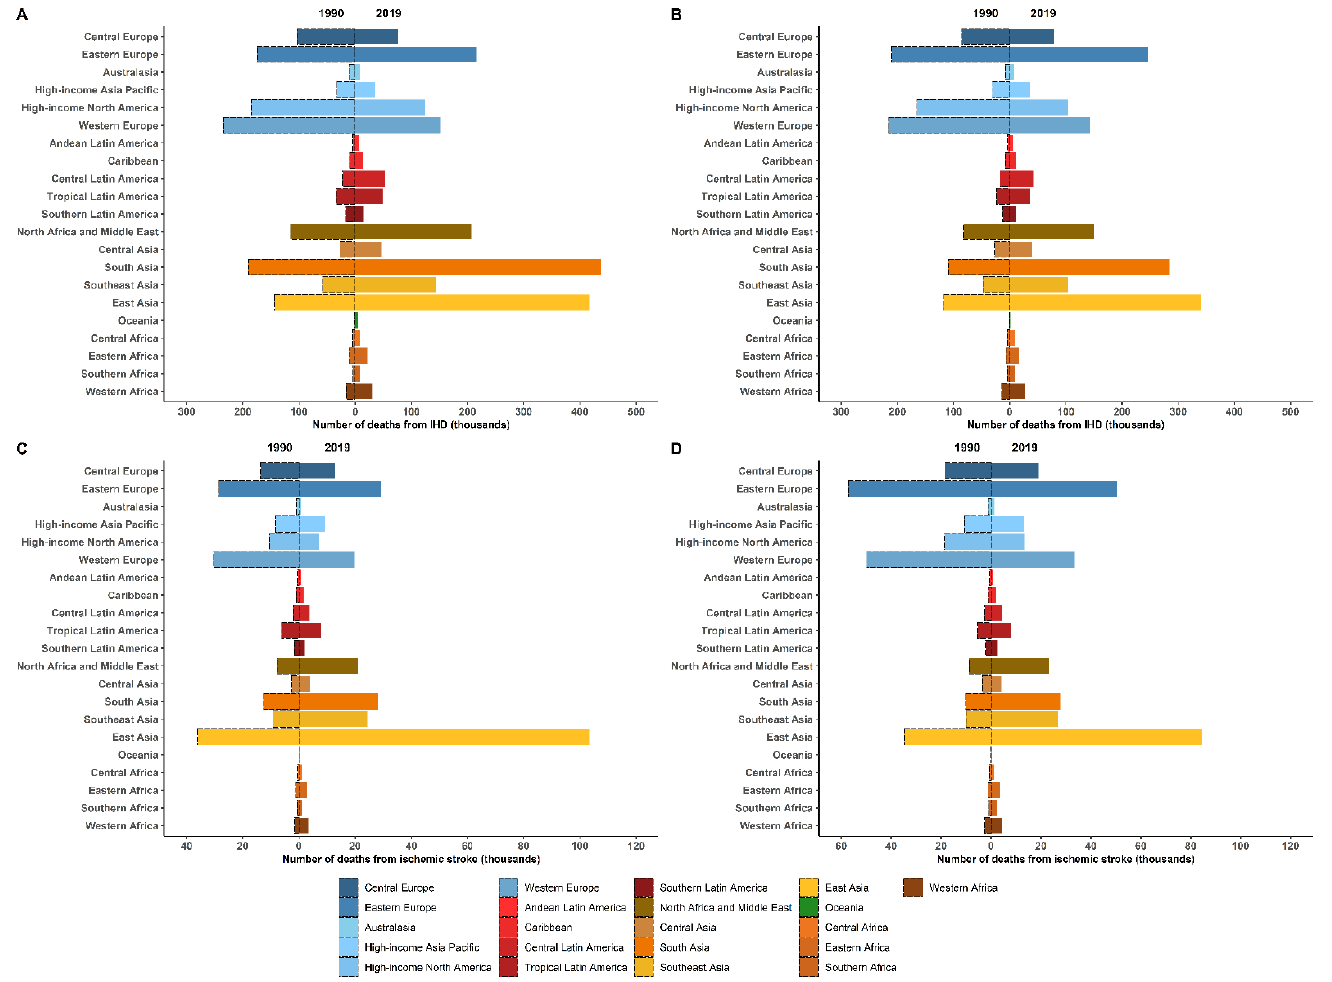
Figure 3. Change in deaths from ischemic heart disease and ischemic stroke attributable to high low-density lipoprotein cholesterol by region in 1990 and 2019. ( A ), Change in deaths from ischemic heart disease attributable to high low-density lipoprotein in men. ( B ), Change in deaths from ischemic heart disease attributable to high low-density lipoprotein in women. ( C ), Change in deaths from ischemic stroke attributable to high low-density lipoprotein in men. ( D ), Change in deaths from ischemic stroke attributable to high low-density lipoprotein in women. Data obtained from GBD database available on https://vizhub.healthdata.org/gbd-results/ (accessed on 1 July 2022) [14]. Abbreviations: IHD, ischemic heart disease.